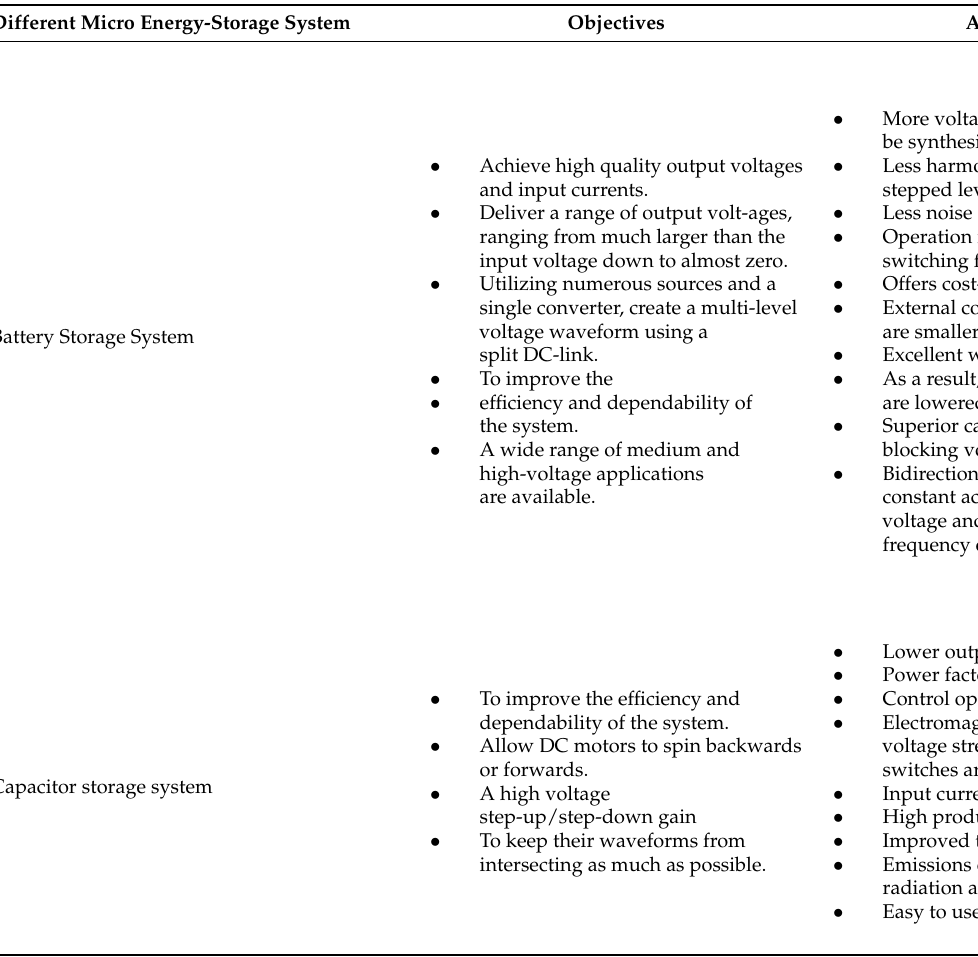
Table 4. A comparison of various micro-energy storage systems that are used in energy